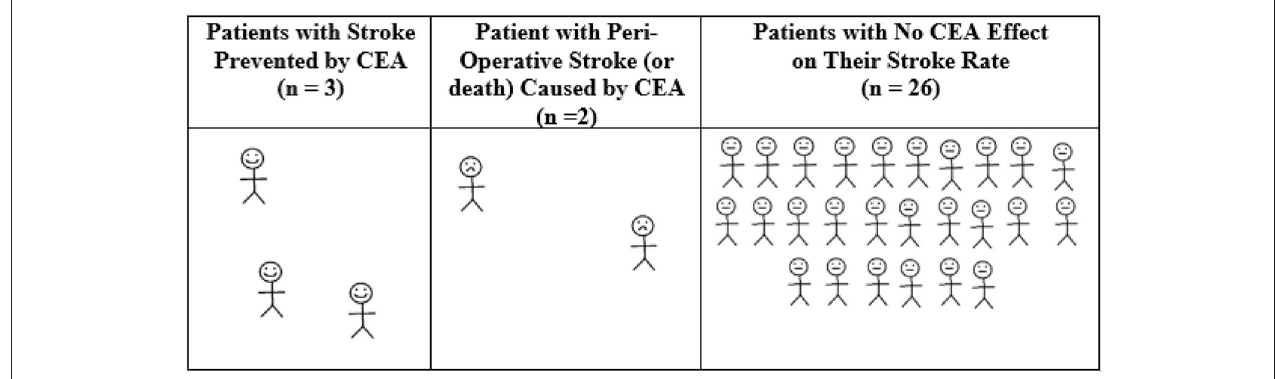
FIGURE 2 | Average 12-month outcomes for every 31 symptomatic patients randomized to CEA in NASCET, ECST, and VACS. Calculated from pooled randomized trial data regarding symptomatic patients with 70–99% stenosis (using “NASCET criteria” and excluding near occlusion), the overall absolute stroke risk reduction with CEA and the overall 30-day CEA rate of stroke or death of 6.2% (4). There was a 16% reduction in any peri-operative stroke/death or later ipsilateral stroke with CEA over 5 years using Kaplan Meier analysis ( ∼ 27.0% with medical intervention alone vs. 11.0% with CEA, or 3.2%/year risk reduction with CEA) (4). Therefore, the number needed to treat by CEA to be ahead by 1 ipsilateral stroke over 12 months of study follow-up was 100/3.2 = 31.25 ( 40). Derived from a figure originally published in Fast Facts, 2012, and now with a correction ( © S. Karger AG, Basel)